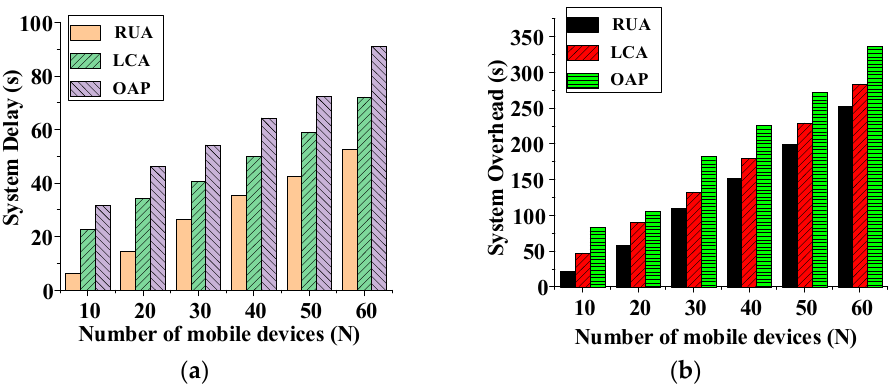
Figure 8. Influence of the mobile device number on the system delay and system overhead: ( a ) the changing trend of the system delay with the increase in mobile devices; ( b ) the changing trend of the system overhead with the increase in mobile devices.